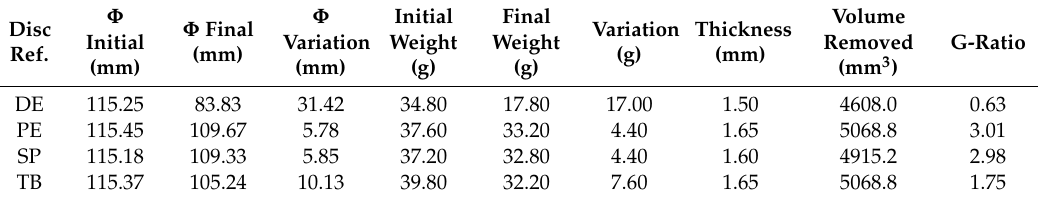
Table 1. Diametric wear, weight wear and G-Ratio results (average